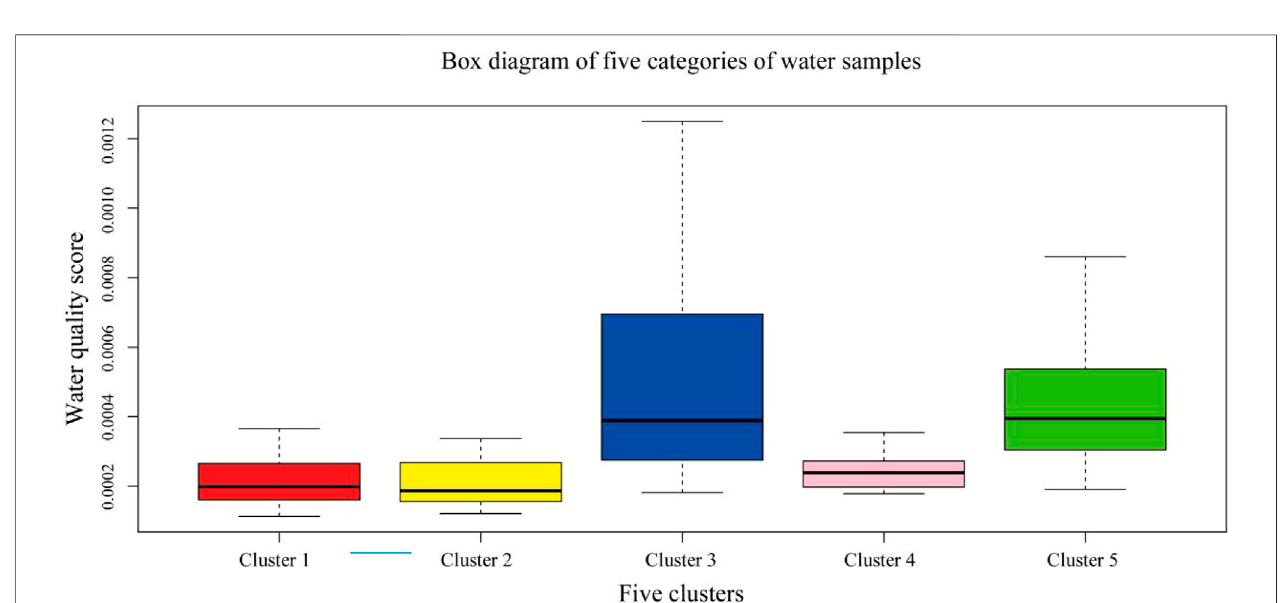
FIGURE 7 | Water quality score of the fi ve clusters.